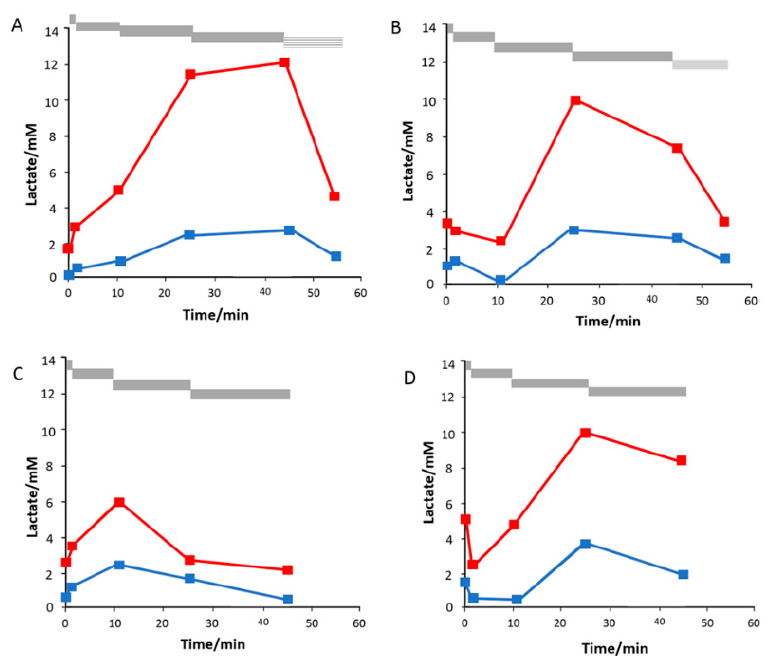
Figure 9. Lactate monitoring in four subjects ( A – D ) undergoing the similar graded exercise. The blue curves show measurements on saliva collected at defined points of the exercise. The red curves indicate parallel blood lactate measurements. The horizontal grey bars represent the following assay points: pre-exercise, and then at the end of a sequence of 1 min, 10 min, 15 min and 20 min exercise. Shaded bars represent 10 min post-exercise rest periods in two subjects ( A , B ). Needle electrode used for measurement had a permselective electropolymerized inner barrier layer of poly(phenol red)/poly(4-aminophenol) instead pf SPEES PES. Details of the electropolymerisation are provided in [13].